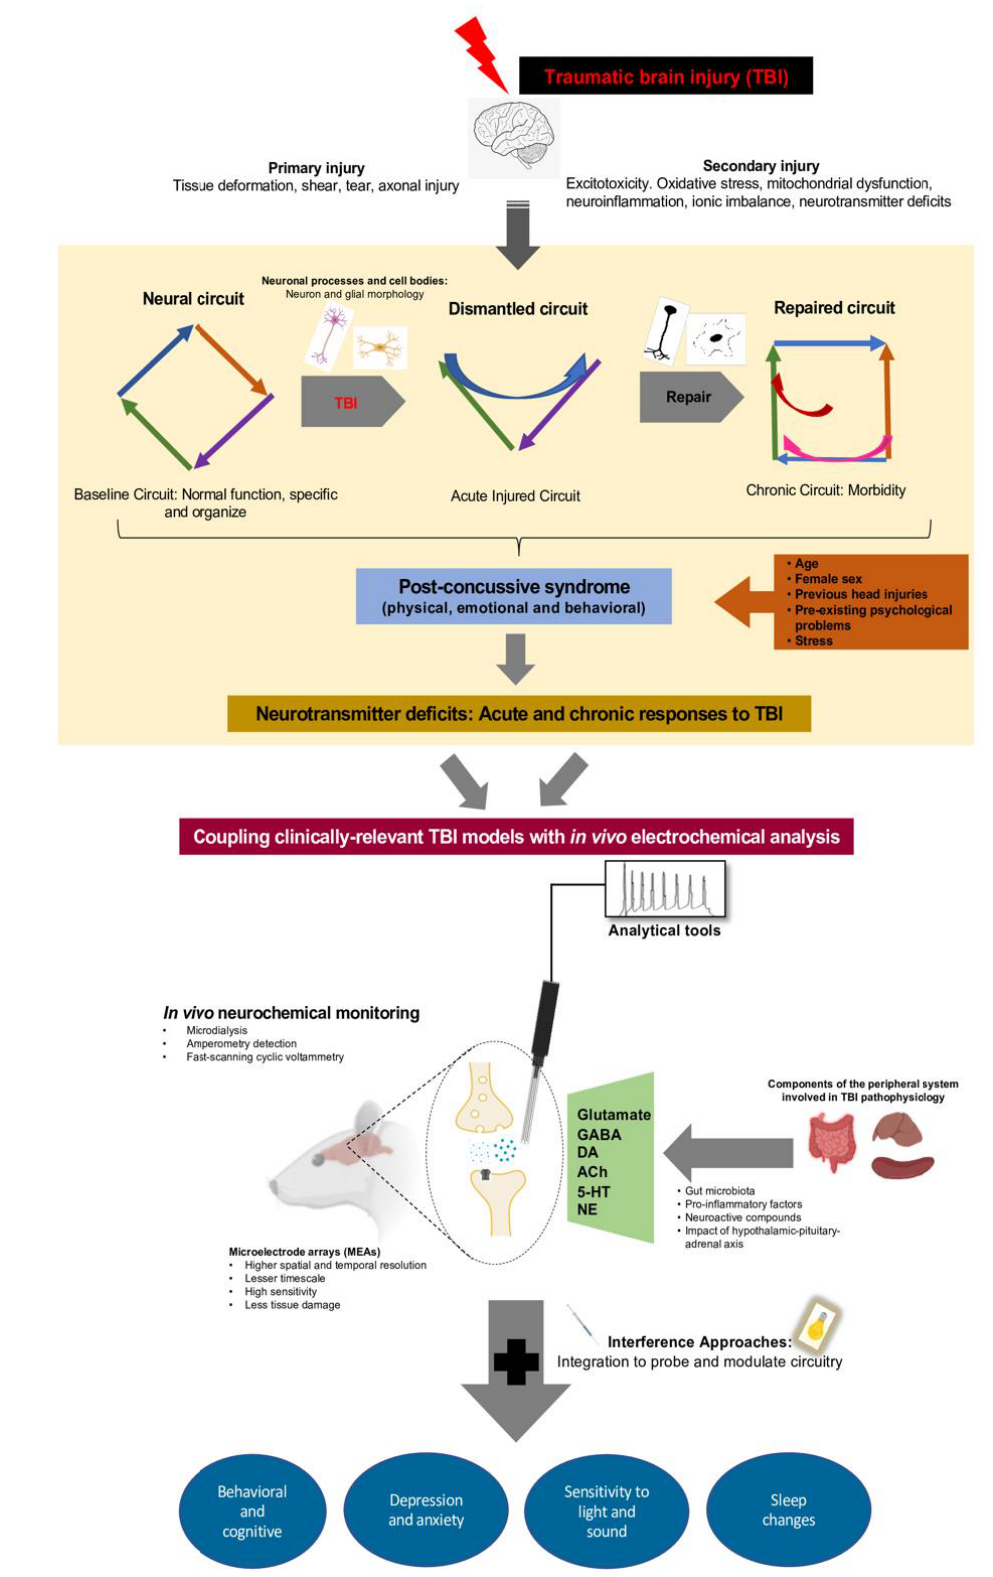
Figure 1. Cartoon summary highlighting the approaches to monitor circuit disruption and behavioral manifestations after traumatic brain injury (TBI). Mild TBI initially manifests as primary and secondary injuries leading to acute and chronic neurological deficits, contributing to morbidity of